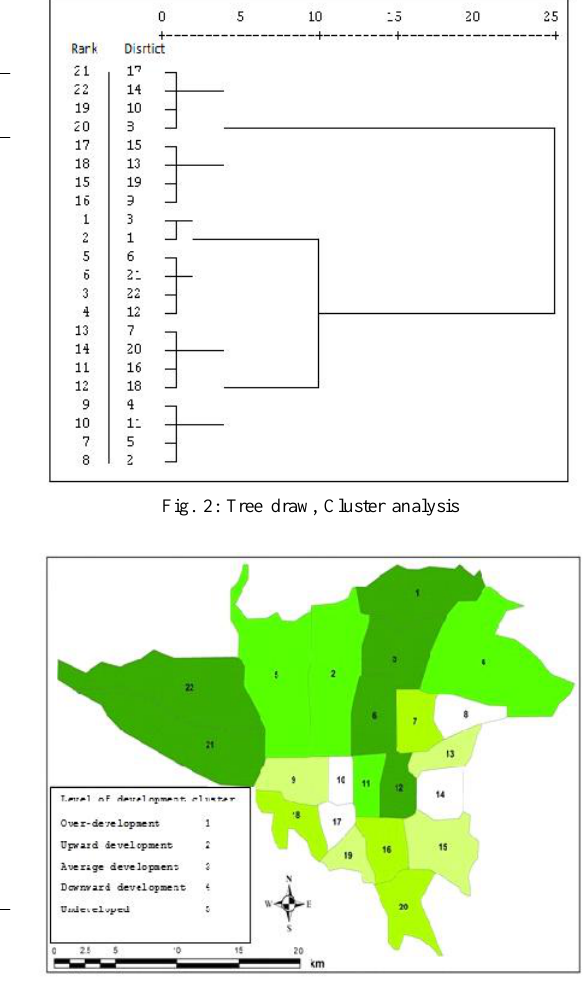
Fig. 3: level of development